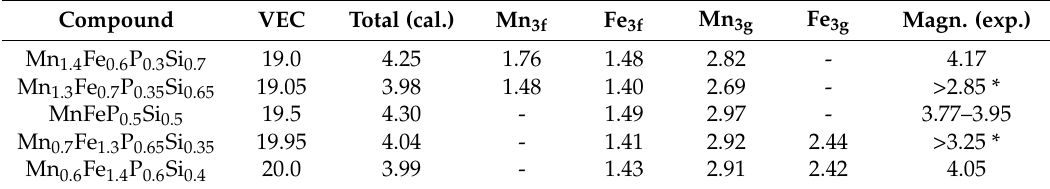
Table 5. Total (per formula) and site-decomposed magnetic moments (per atom) in selected